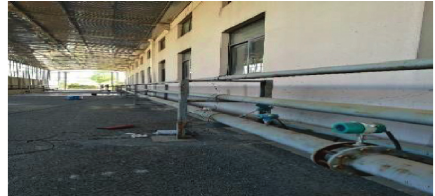
Figure 1: Pipeline multisource leakage test